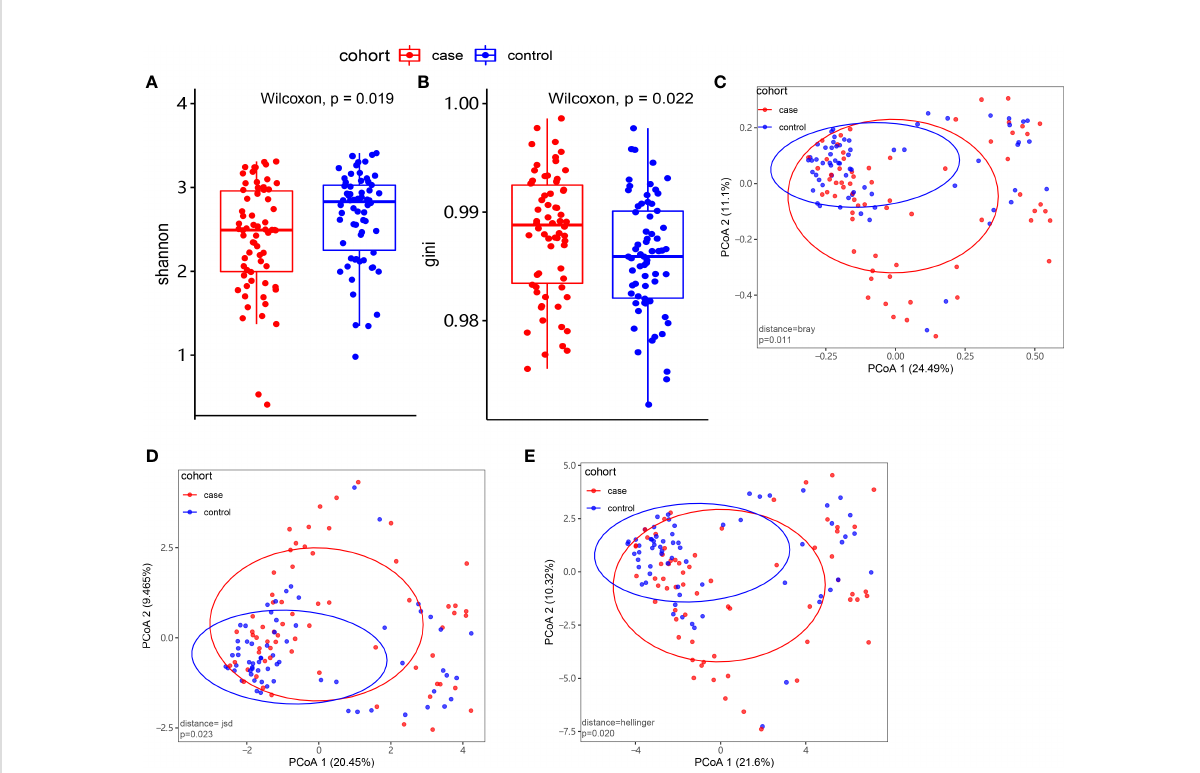
FIGURE 2 Microbiome composition and diversity. (A, B) Alpha diversity by Shannon and Gini indexes between the case group (N = 66) and control group (N = 66). (C – E) Beta diversity by Bray, Hellinger, and Jensen – Shannon divergence (JSD) indexes between the two